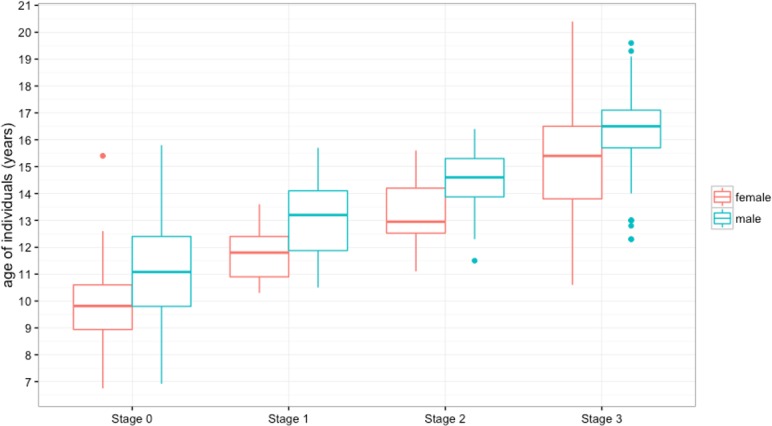
Distribution of study population according to age, sex, and spheno-occipital synchondrosis closure Stage (median and quartile range).See Table 3 for data.